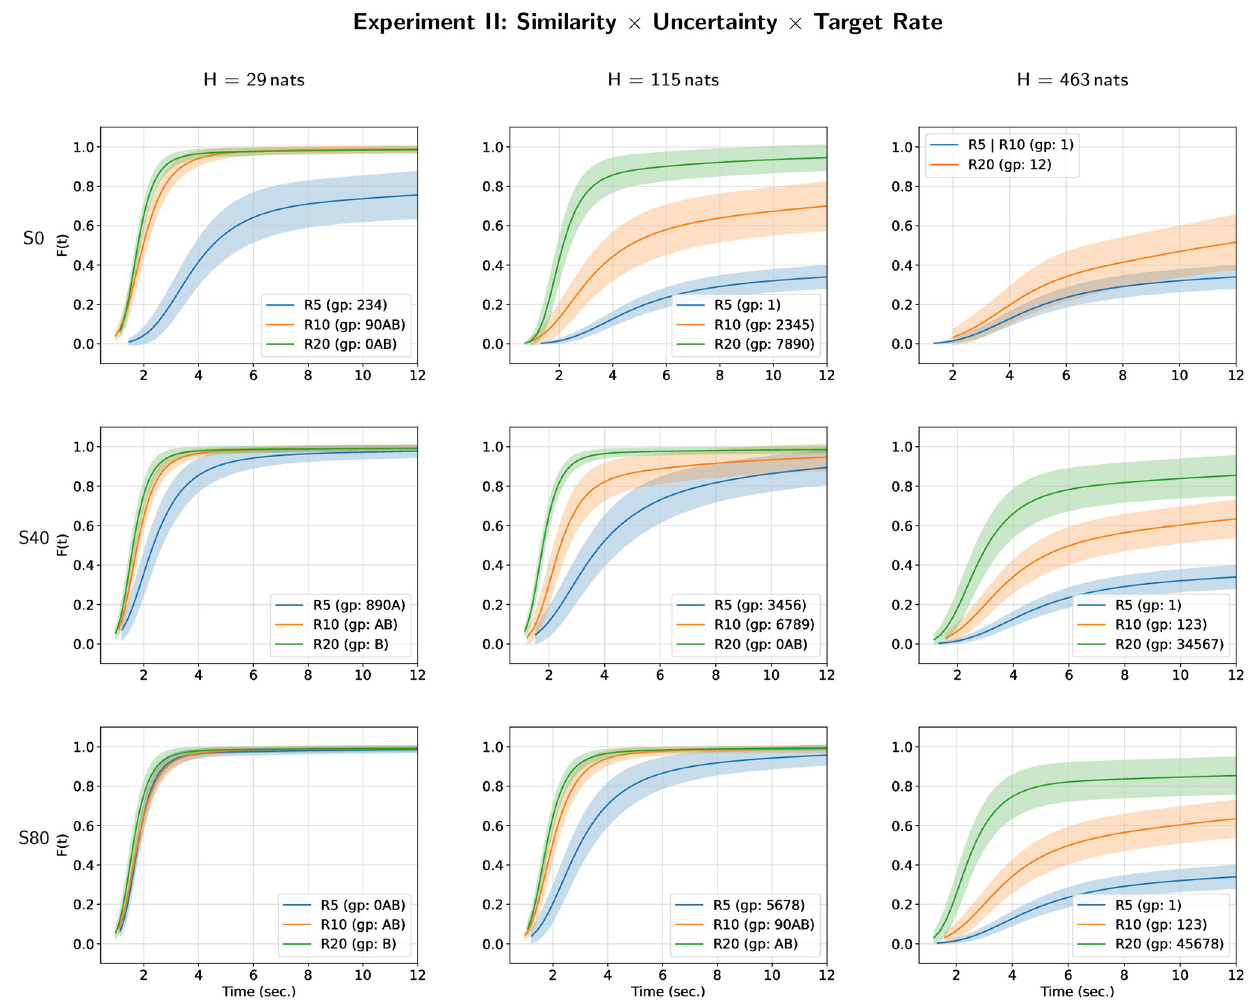
Fig 6. Cumulative distributions functions F ( t ) for masker uncertainty, masker-target similarity and target repetition rate in Experiment II. Each figure depicts the estimates of the cumulative distribution functions for each different group of the compact letter display for experimental conditions defined by the interaction between masker uncertainty, masker-target similarity and target repetition